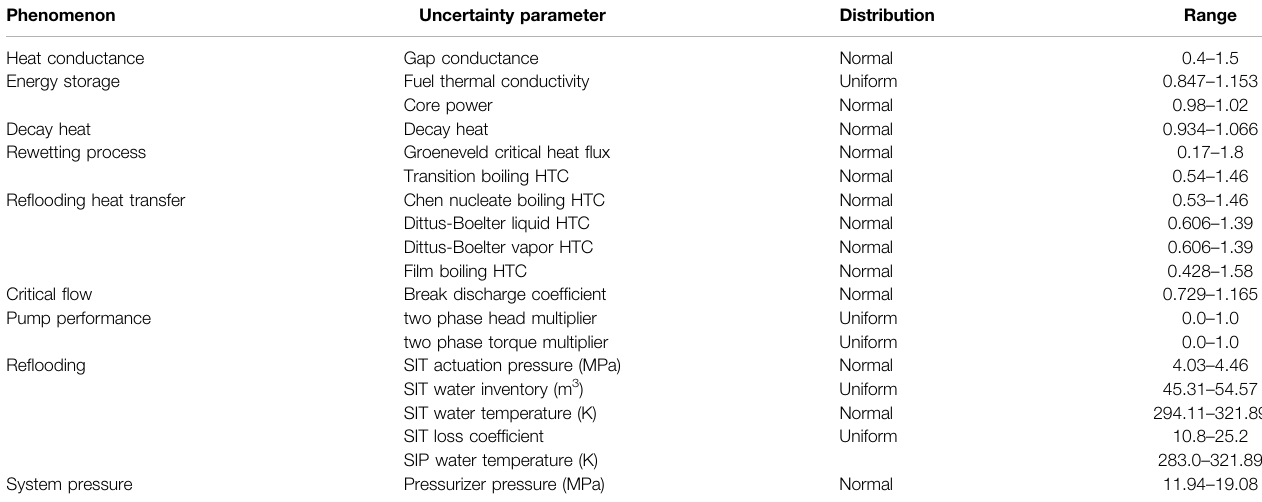
TABLE 2 | Key uncertain phenomena and associated uncertain parameters.